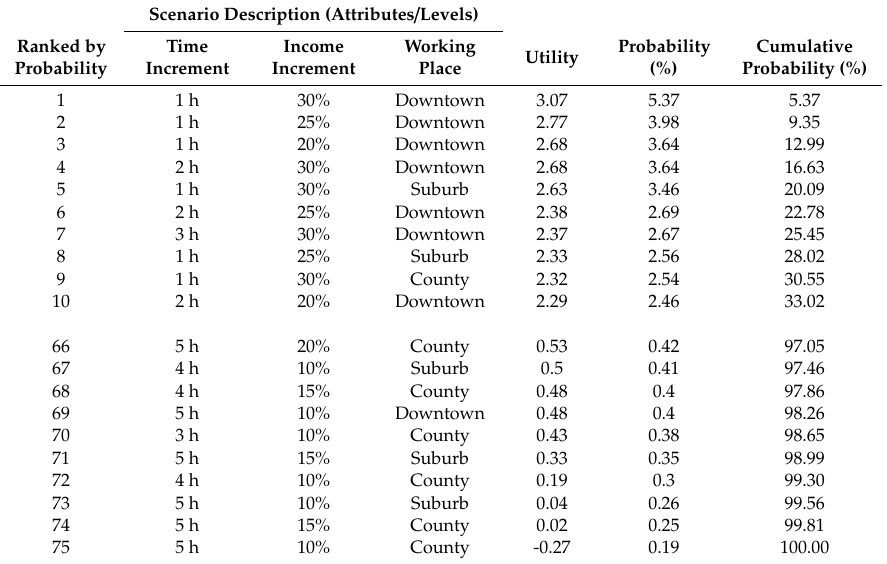
Table 5. DCE model: estimated utility score by selected scenario based on main e ff ect